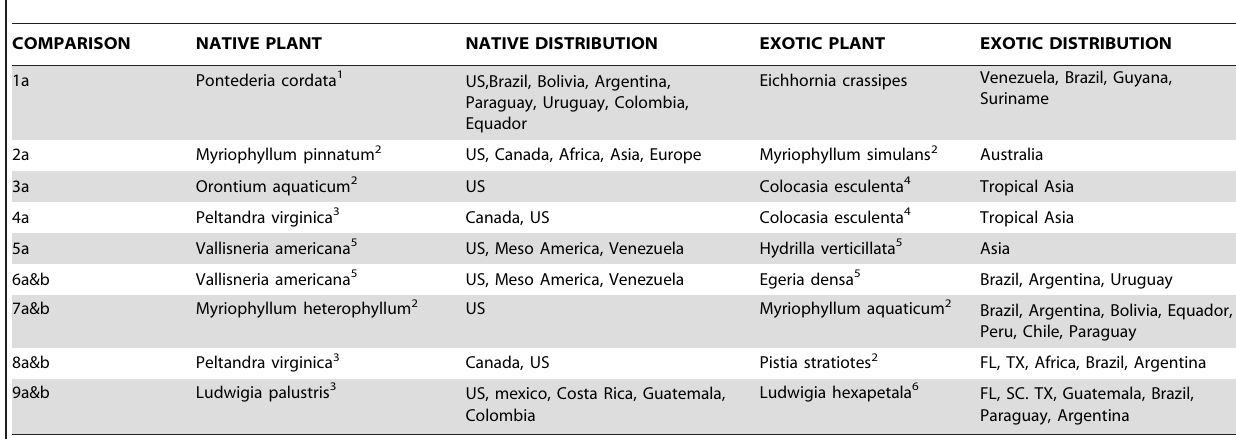
Table 1. Confamilial plant pairs used in feeding assays with information on native distributions [36].